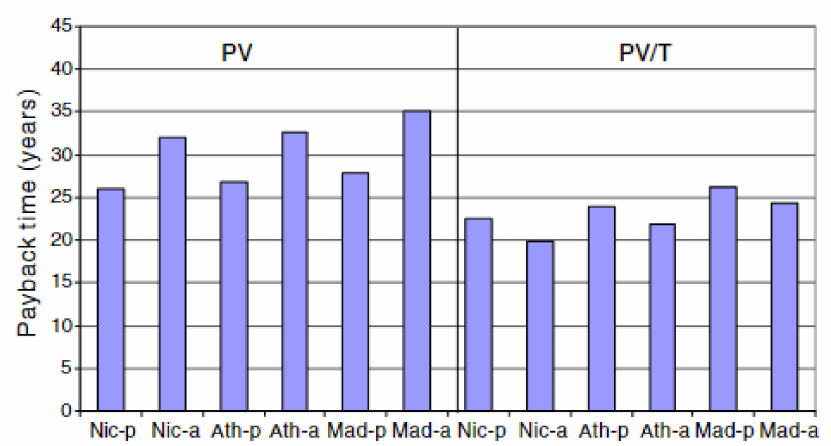
Figure 33. Payback times of conventional PV and hybrid PVT system for three different locations (Ni— Nicosia, Ath—Athens, Mad—Madison) and two PV technologies (p—polycrystalline, a—amorphous) (reprinted from [72], with permission from publisher).